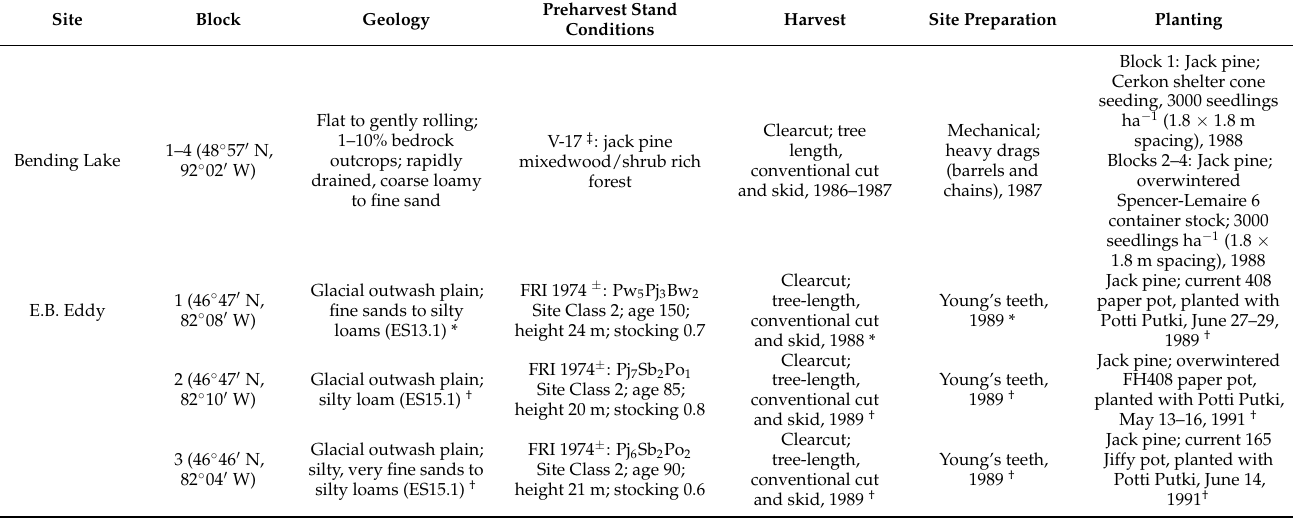
Table 1. Description of jack pine release study areas in northwestern Ontario,